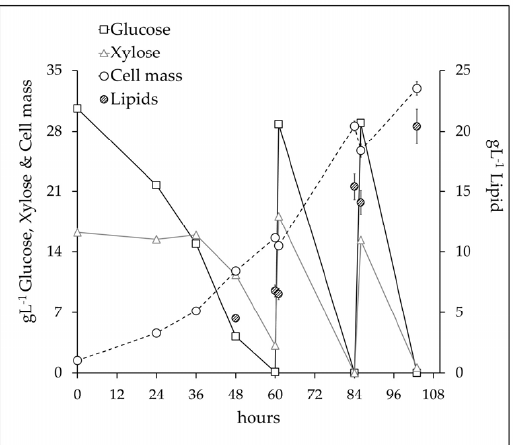
Figure 3. Microbial lipid production by L. tetrasporus DSM 70314 during 10 L fermentation in fed-batch mode. Profiles of cell mass, glucose, xylose, and